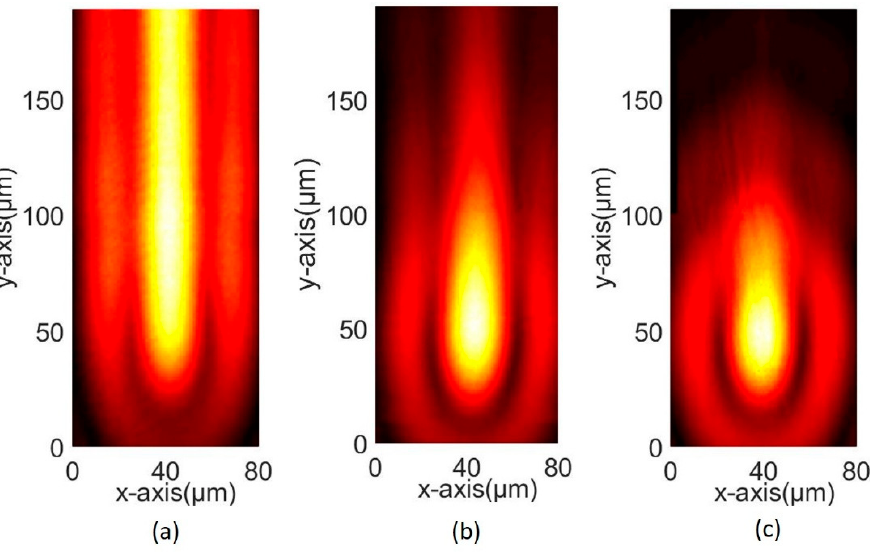
Figure 4. Near-field amplitude distribution acquired by MH-SNOM demonstrating BSW propagation for ( a ) Bare multilayer; ( b ) Monolayer graphene; and ( c ) Bilayer graphene.